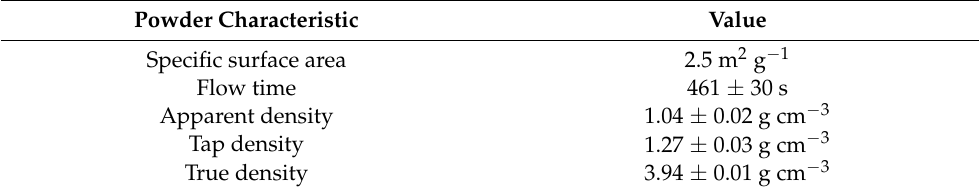
Table 3. Summary of the alumina powder characteristics. Powder